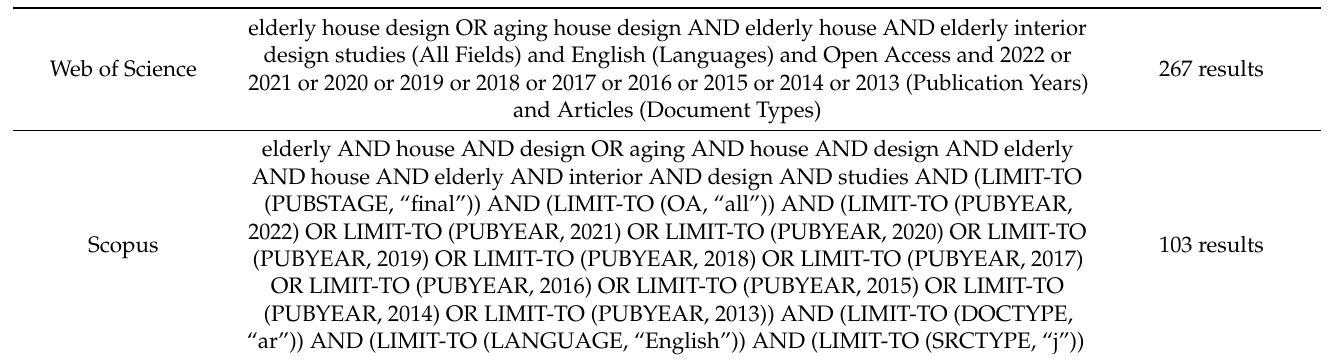
Table 2. Search strings from Web of Science and Scopus.